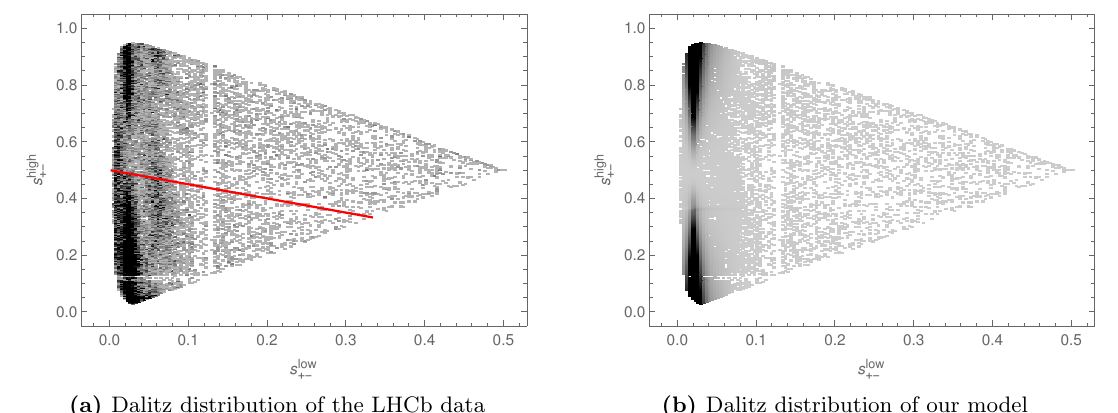
Figure 3. Dalitz distribution for B (cid:0) ! (cid:25) (cid:0) (cid:25) + (cid:25) (cid:0) (a) as measured by the LHCb Collaboration [7] where the region below the line corresponds to cos (cid:18) (cid:25) > 0 line as discussed in the text (b) Dalitz distribution of our model including